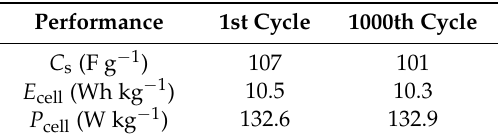
Figure 9. ( a ) Cyclic voltammetry (CV) curves at different scan rates in the potential range of 0 – 2 V, ( b ) cycling durability at 0.4 A g − 1 over 1000 cycles for the EDLC fabricated with the P-40-10 electrolyte system. Table 3. Specific capacitance, energy density, and power density of the EDLC at a current density of 0.4 A g –1 under a working voltage of 2 V.